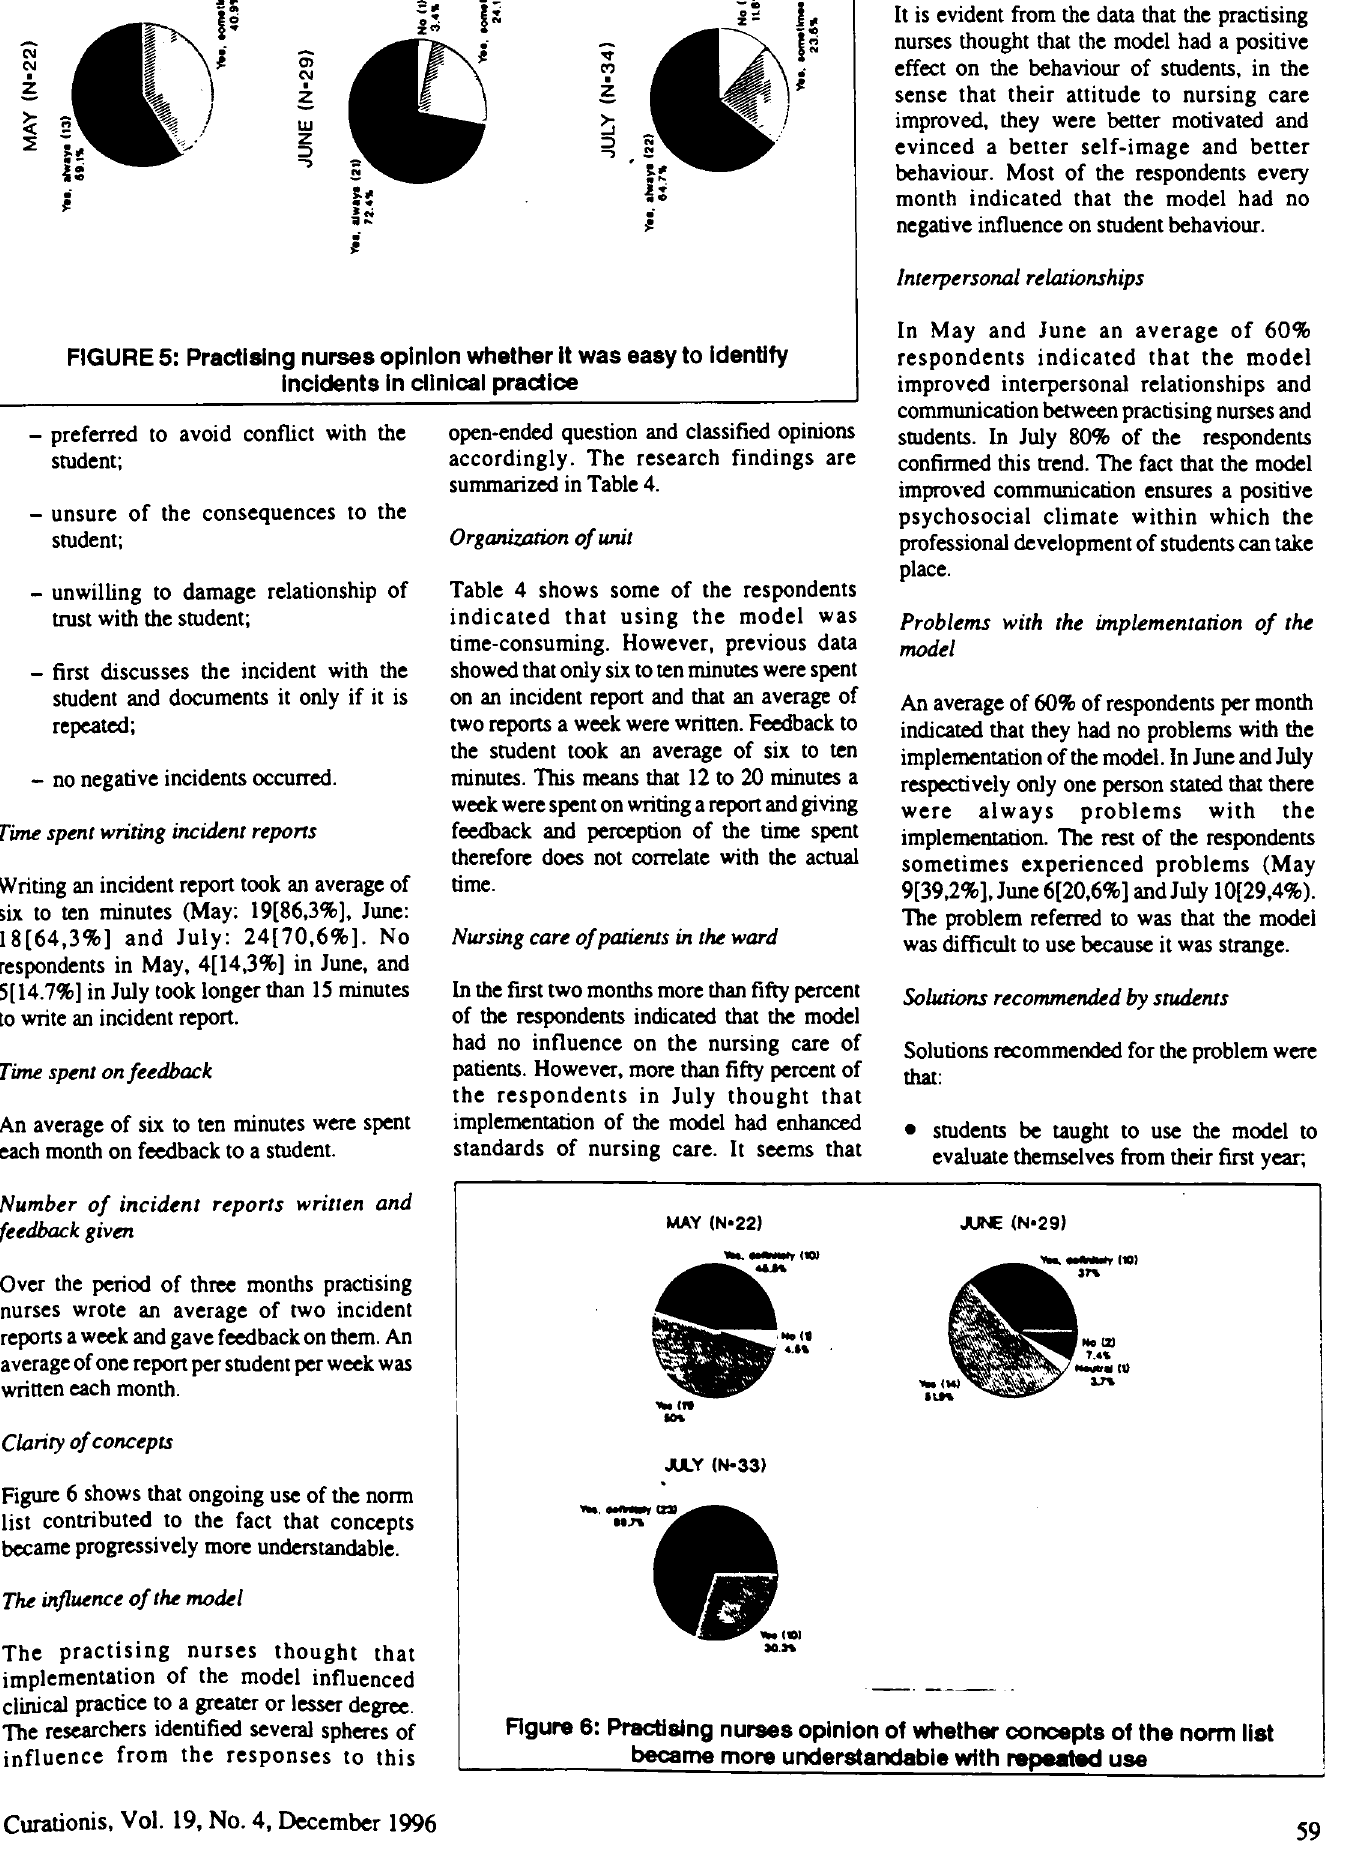
FIGURE 5: Practising nurses opinion whether it was easy to identify incidents in dlnical practice